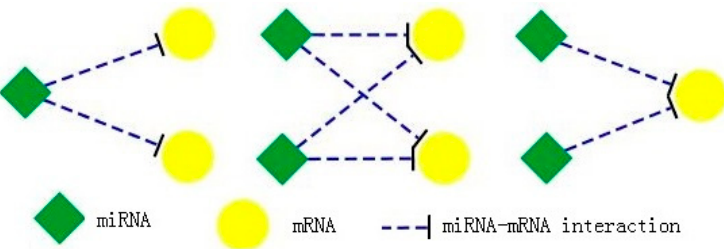
Figure 2. Three types of maximal miRNA-mRNA bicliques. In the miRNA regulation network, there are many types of maximal miRNA-mRNA bicliques. Their R _ density values are all 1.